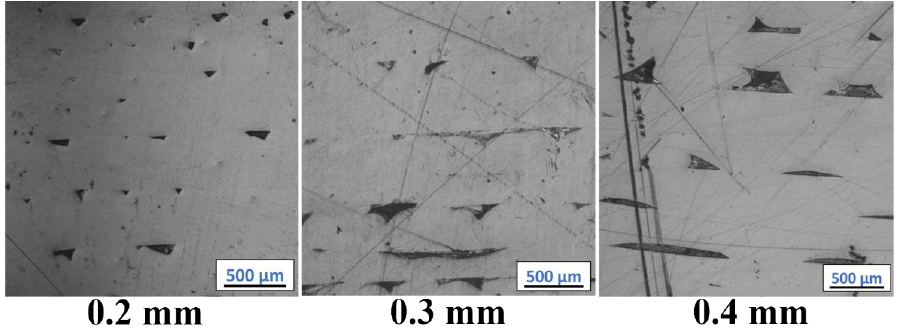
Figure 10. Microstructure and porosity of Premium ABS as a function of layer height. Views at the interior of the printed samples are shown. Table 2. Porosity percent area determinations of optical images in Figures 9 and 10.